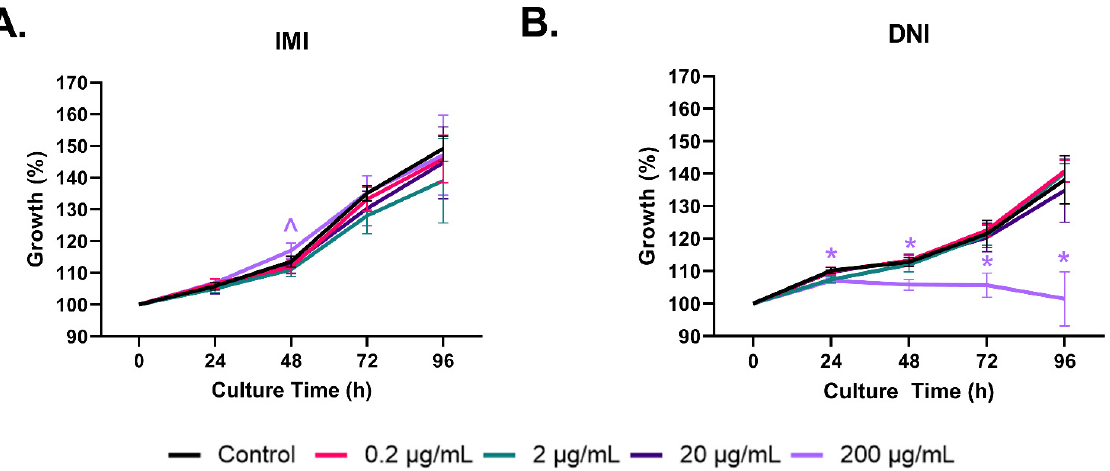
Figure 1. Effects of IMI ( A ) and DNI ( B ) on antral follicle growth. Antral follicles were treated with vehicle (DMSO or water), IMI, or DNI (0.2–200 µ g/mL) for 96 h. Follicle growth was measured every 24 h. The graphs indicate means ± SEMs from 3–10 separate cultures (8–12 follicles per treatment per culture). * p ≤ 0.05; ˆ 0.05 < p ≤ 0.10.